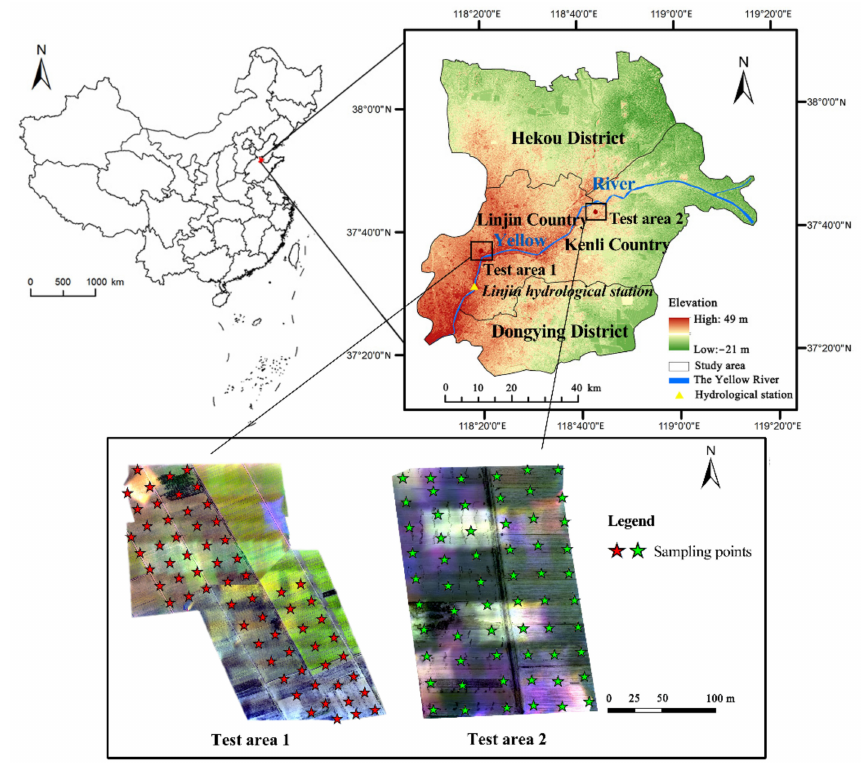
Figure 1. Sketch map of the research area based on elevation and distribution map of sampling points in the test